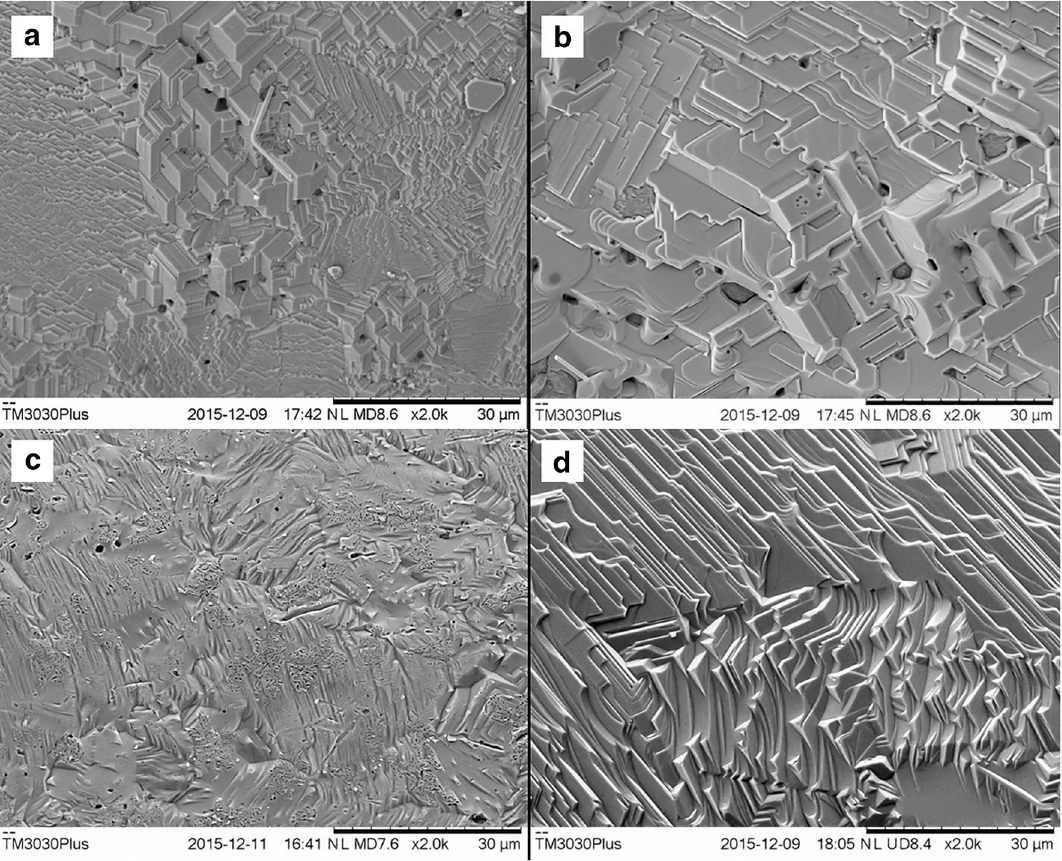
Fig. 5 SEM scans of the surface of Ag interconnect wire (1 cm from the cell) after test under constant current for 850 h at 650 °C: a , b cathode lead; c anode lead; d the surface of Ag cathode wire after 450 h at 700